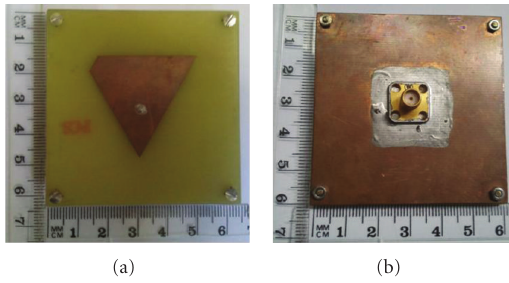
Figure 13: Developed 2.487 GHz antenna: left-radiation face, right- ground face with 3 mm Via.